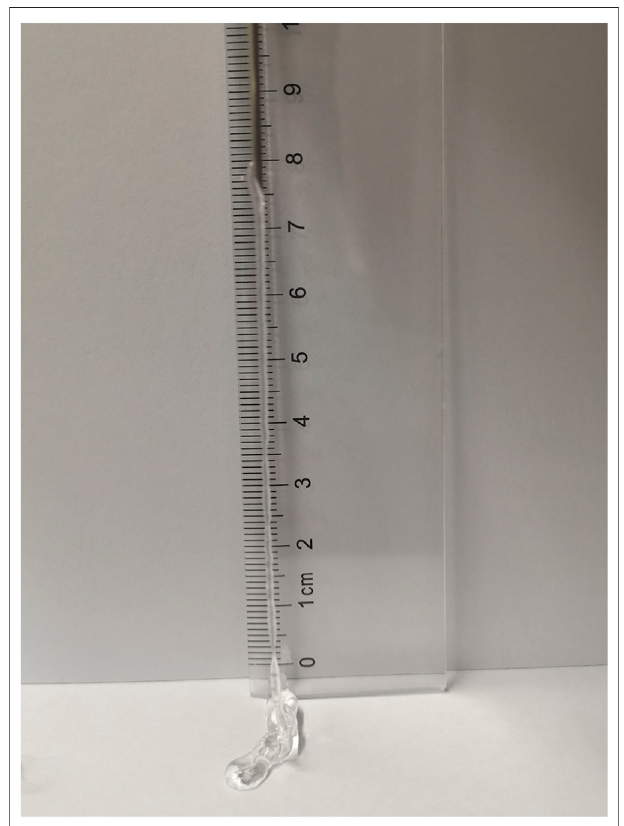
FIGURE 2 | The photograph of the HA-engineered hydrogel extruded from the syringes through an 18-gauge cannula.